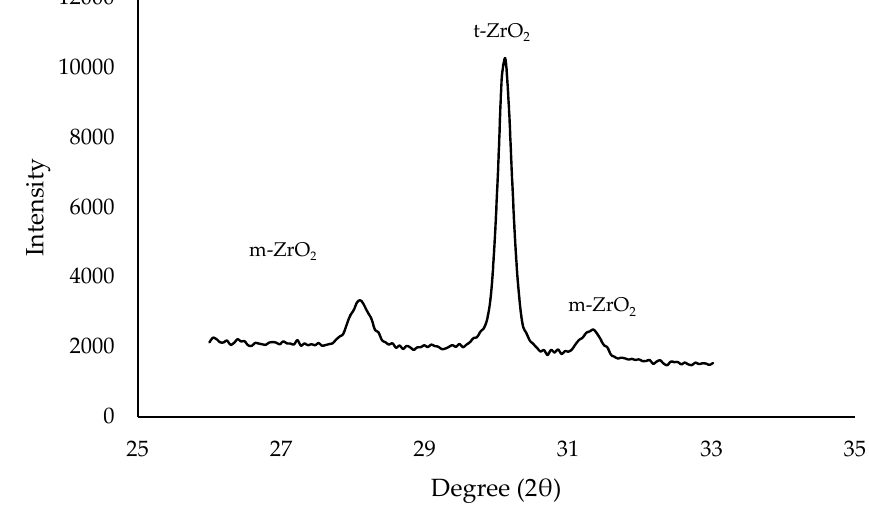
Figure 1. Exemplary X-Ray Diffraction (XRD) pattern acquired at the surface of a zirconia implant showing tetragonal (region of 30° 2 θ ) and monoclinic peaks (in the region of 28.2° 2 θ and 31.4° 2 θ ). Quantification of monoclinic and tetragonal fractions is based on the respective intensity (area) of the peaks.